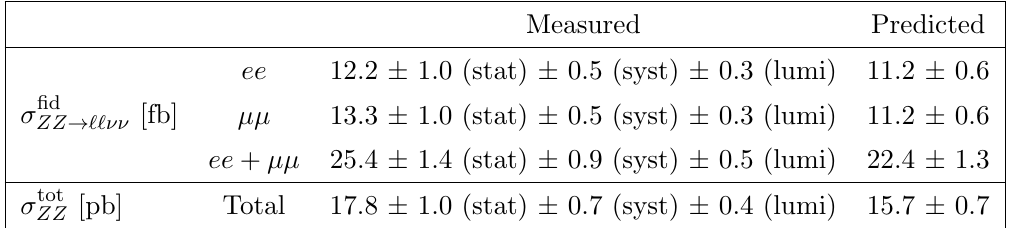
Table 8 . Measured and predicted integrated cross-sections in the (cid:12)ducial and total phase spaces, together with the breakdown of their uncertainties. The luminosity uncertainty is quoted separately from the other systematic uncertainties. The measurements are also shown separately for the ee and (cid:22)(cid:22) channels in the case of the (cid:12)ducial cross-section. measurement is about 13% higher than the prediction, which is not signi(cid:12)cant given the size of the measurement and prediction